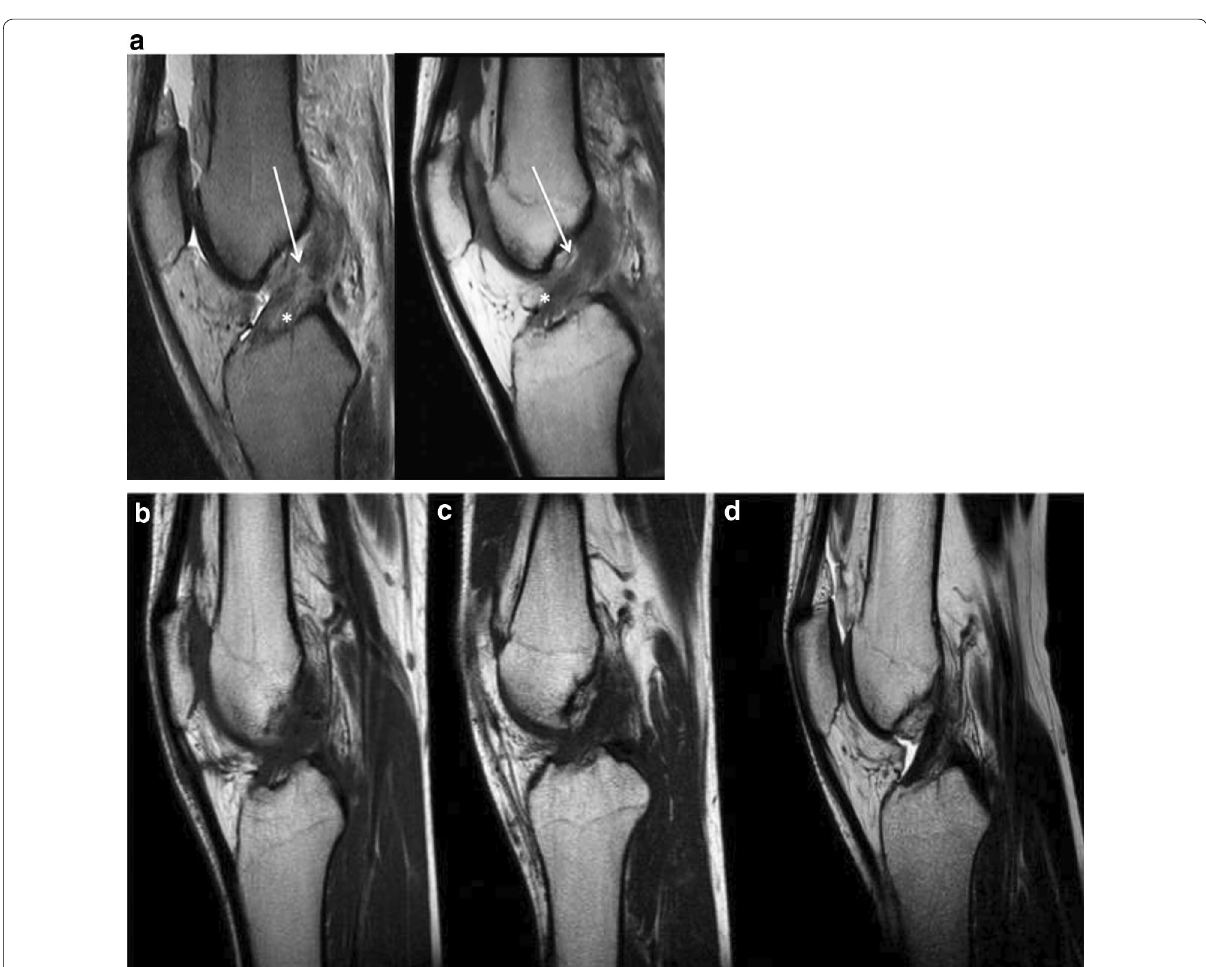
Fig. 2 Pre- and postoperative images of patient #5. a Sagittal preoperative MRI T2-TSE (left) and T1-TSE (right). Tear location (arrow): type III; tissue quality (asterisk): good b Sagittal T1-TSE 1 month post-op. Morphology: grade 1 (normal); signal intensity: grade 2 (intermediate) c Sagittal T1-TSE 3 months post-op. Morphology: grade 1 (normal); signal intensity: grade 1 (isointense) d Sagittal T1-TSE 6 months post-op. Morphology: grade 1 (normal); signal intensity: grade 1 (isointense) TSE turbo